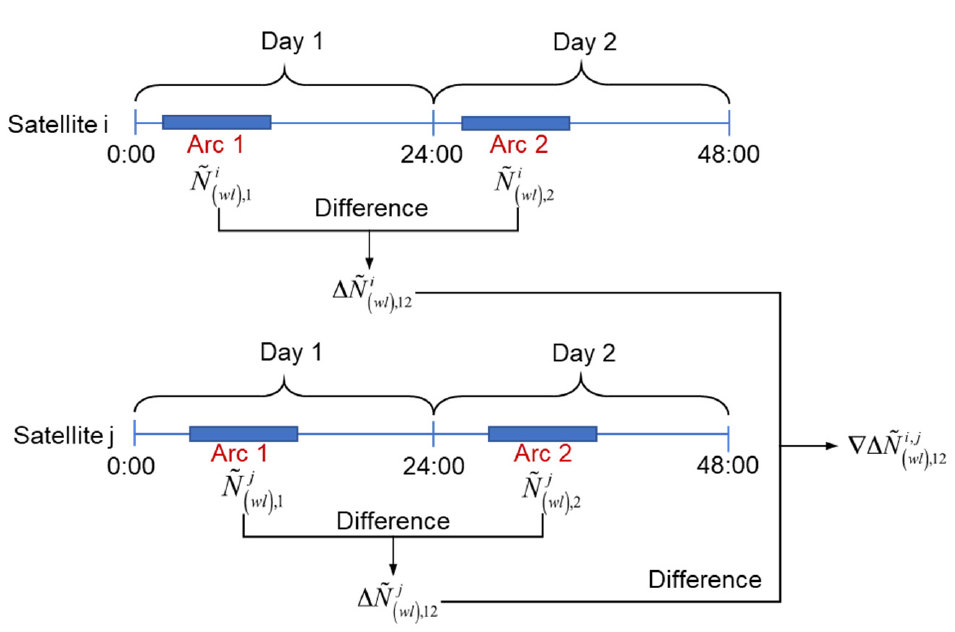
Figure 1. The diagram of forming DD WL ambiguity.